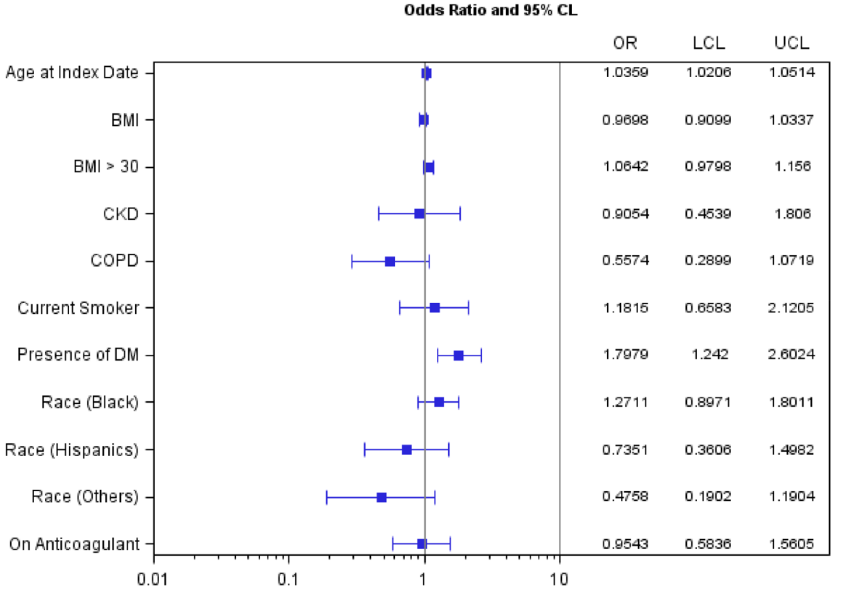
Figure 4. Odds ratios and 95% confidence interval estimates of risk factors for 60-day new diagnosis of heart disease among SARS-CoV-2-positive women veterans. BMI: Body Mass Index; CKD: Chronic Kidney Disease; COPD: Chronic Obstructive Pulmonary Disease; CVD: cardiovascular disease; DM: Diabetes; OR: Odds Ratios; CI: Confidence Intervals; LCL: Lower Confidence Limit; UCL: Upper Confidence Limit. a. 95% CI excluding 1 indicates statistical significance at α =